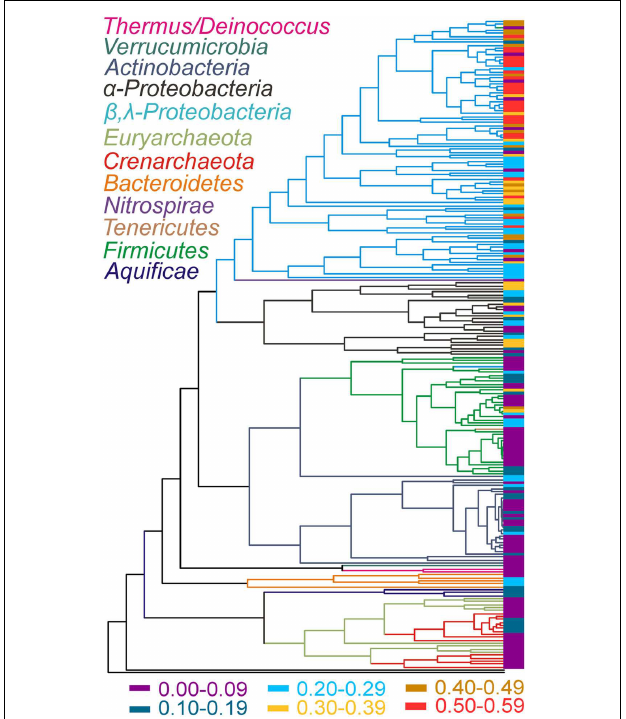
FIGURE 2 | Rate smoothed MerA phylogenetic tree (plasmid MerA were not included) with the complexity index of the mer operon associated with each MerA terminal indicated. The complexity index (indicated by the color at the sequence terminals and defined at the bottom) was calculated as the sum of the presence (value of 1) or absence (value of 0) of individual mer genes divided by 13 (a total of 13 individual mer -encoded genes). Lineages are color coded to indicate the phylum level taxonomy of each lineage with the exception of the proteobacterial phyla, which was further delineated to indicate Alpha ( α )- and Beta / Gamma ( β / λ )- proteobacteria